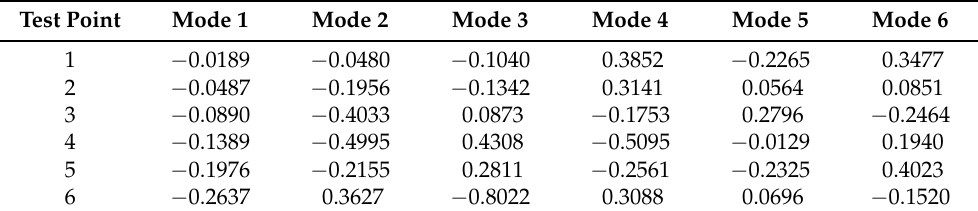
Table 1. Normalized modal vectors.